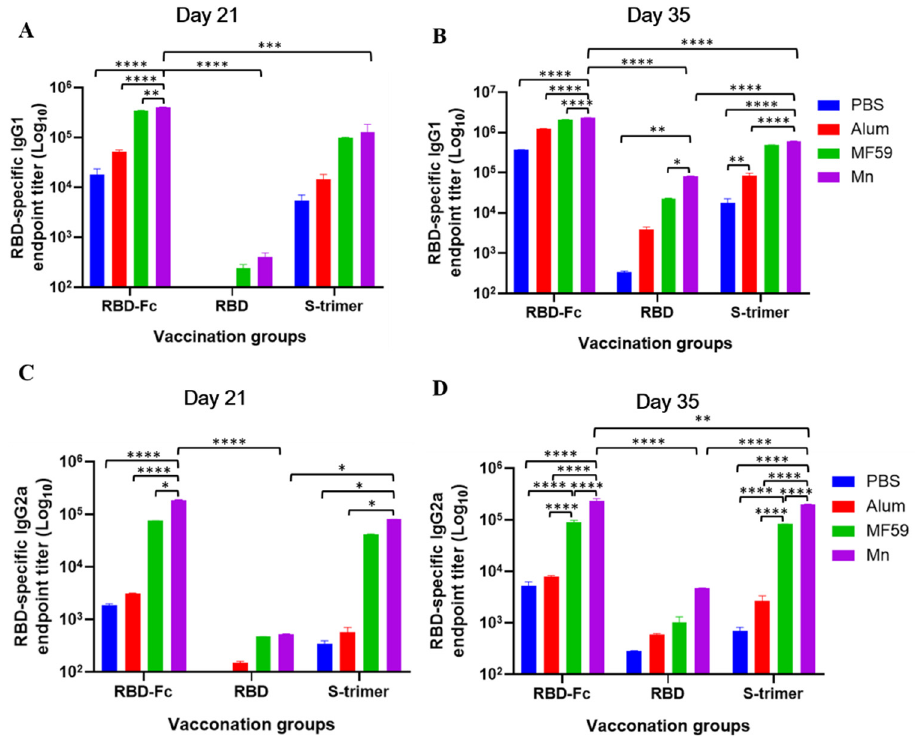
Figure 3. Titers of serum IgG1 and IgG2a antibodies to RBD protein in immunized mouse sera. RBD- specific IgG1 endpoint titer on day 21 ( A ) and on day 35 ( B ) in vaccinated mouse sera. RBD-specific IgG2a endpoint titer on day 21 ( C ) and on day 35 ( D ) in vaccinated mouse sera. Statistical significance was determined by two-way ANOVA and is indicated as follows: * p < 0.05, ** p < 0.01, *** p < 0.001, **** p < 0.0001. Error bars represent SD.